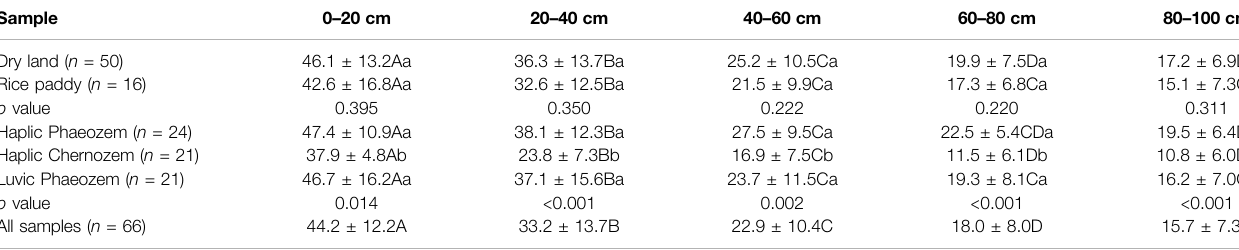
TABLE 1 | Different depths of soil total nitrogen density (STND) distribution under different land use and soil types.